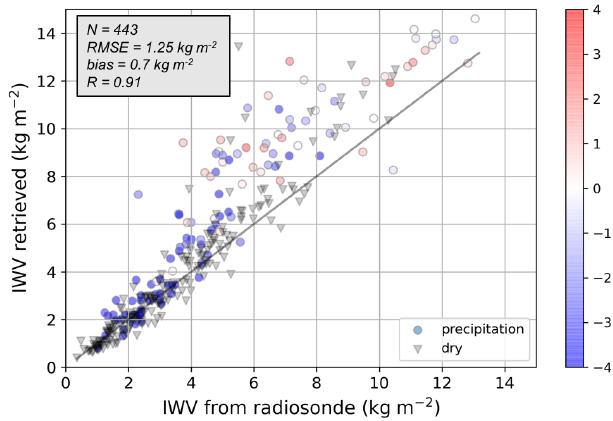
Figure 13. Scatter plot of retrieved IWV vs. IWV computed from radiosonde profiles. The algorithm used for the retrieval is the one with the full set of input features. The color indicates the surface temperature (in ◦ C). Dry conditions are identified with the equiv- alent radar reflectivity in the first kilometer above the radar (with a − 10dB threshold) and are coded as black triangles; precipitating conditions are denoted with circles. The size of the dataset is indi- cated ( N ), as are relevant error metrics (RMSE, mean bias, R